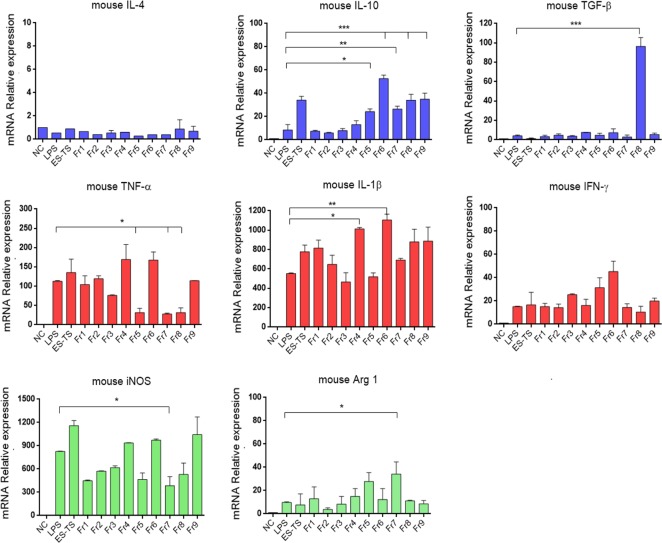
Transcription of cytokines and M1/M2 markers after treatment of mBMDMs with ES-L1 fractions.mBMDMs were treated with each ES-L1 fraction (10 μg/ml) for 24 h before LPS stimulation (100 ng/ml) for 12 h. The cells were harvested, and the transcription levels of mRNA cytokines and M1/M2 markers were determined using qRT-PCR. Negative control (NC) was the medium alone. Glyceraldehyde-3-phosphate dehydrogenase (GAPDH) was used as a housekeeping gene for normalization. Each color of the bar graph is explained: “Blue” Anti-inflammatory cytokines, “Red” Pro-inflammatory cytokines, and “Green” M1/M2 markers. The results are expressed as mean ± SD. The experiments were performed in triplicate with two independent experiments. One-way ANOVA followed by a Bonferroni multiple comparison test were used for analysis: *p < 0.05, **p < 0.01, and ***p < 0.001, represent differences between LPS-stimulated mBMDM treated with each ES-L1 fraction and LPS-stimulated-only mBMDMs.